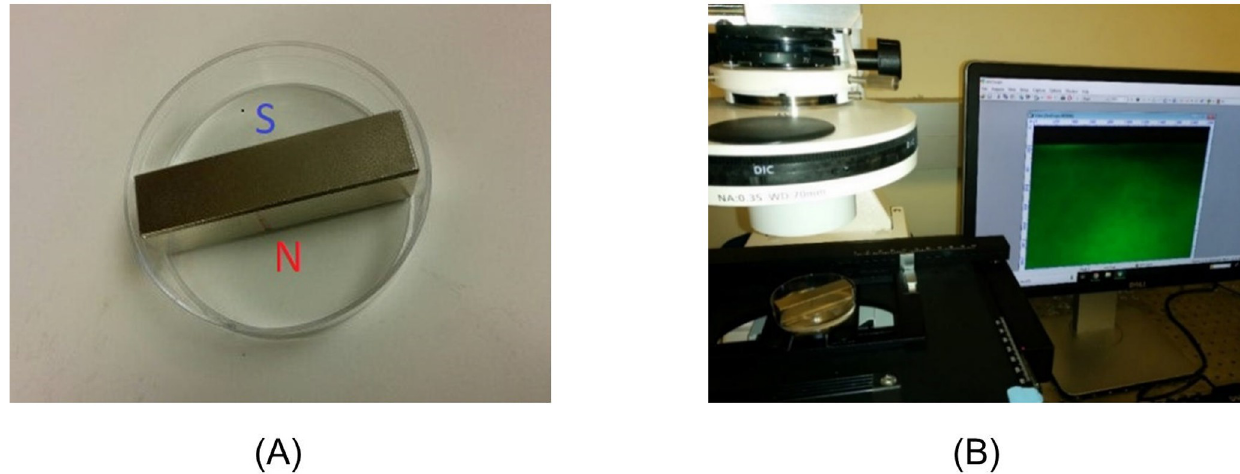
Fig 1. Setup 1 for studying EZ formation. (A) Magnet placed inside of a water-filled petri dish. (B) Microscopic setup for observing EZ formation. The magnets and Petri dishes images are for illustrative purposes only.